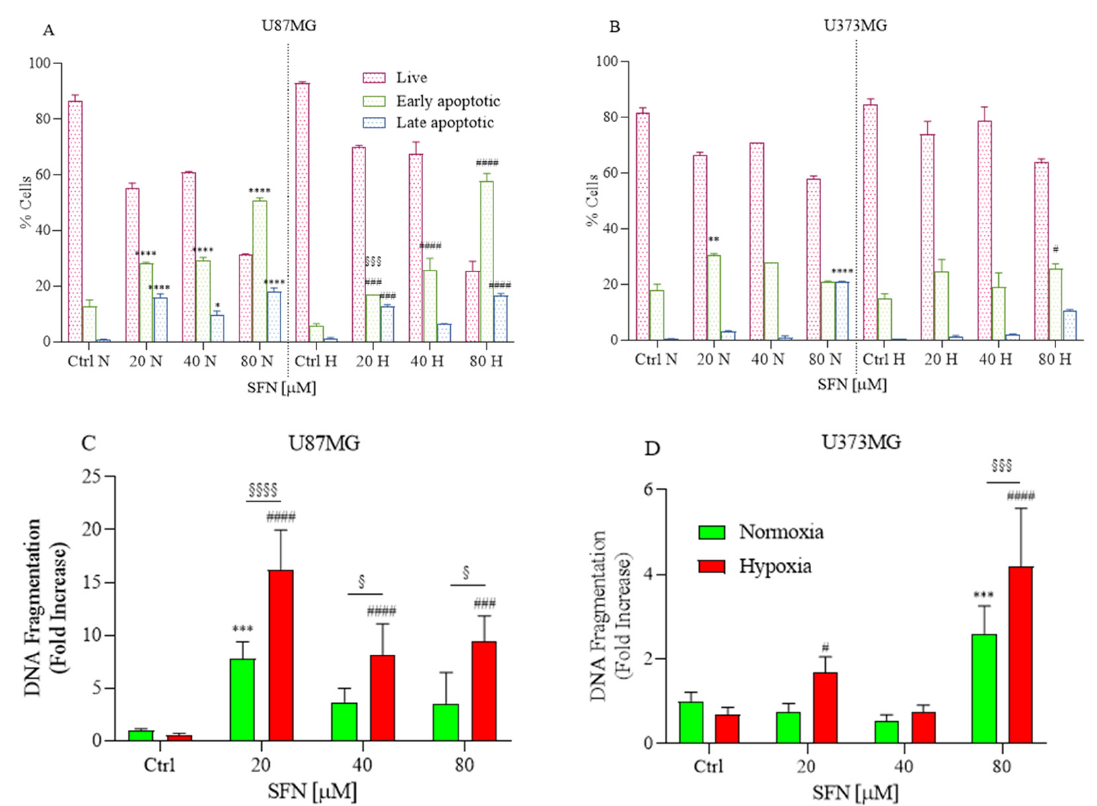
Figure 2. Effects of SFN on caspases-3/-7 ( A , B ) and DNA fragmentation ( C , D ) after 48 h of treatment [20–80 µM] in normoxic or hypoxic conditions. Caspases-3/-7 were detected in U87MG ( A ) and U373MG ( B ) cell lines to identify early (green) and late (blue) apoptosis. The SFN treatment induced apoptosis at 48 h of treatment both in normoxic and hypoxic conditions. DNA fragmentation was detected in U87MG ( C ) and U373MG ( D ) and SFN induced apoptosis in normoxic (green) and hypoxic (red) conditions. Data are expressed as percentage of live, early and late apoptotic cells ( A , B ) or as fold increases in DNA fragmentation versus corresponding controls ( C , D ) and reported as mean ± SD of three independent experiments (* p < 0.05, ** p < 0.01, *** p < 0.001 and **** p < 0.0001 vs. normoxic Ctrl group; # p < 0.05, ### p < 0.001, and #### p < 0.0001 vs. hypoxic Ctrl group; § p < 0.05, §§§ p < 0.001 and §§§§ p < 0.0001 vs. the respective normoxic treatment group. Two- way ANOVA, post hoc test Bonferroni).